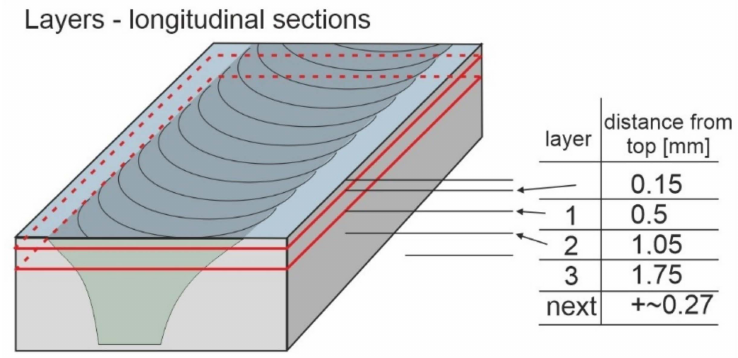
Figure 1. Multilayer weld metal and the scheme of performing longitudinal